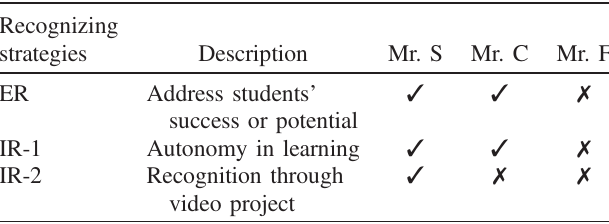
TABLE V. Recognizing strategies applied by the three teachers. Recognizing